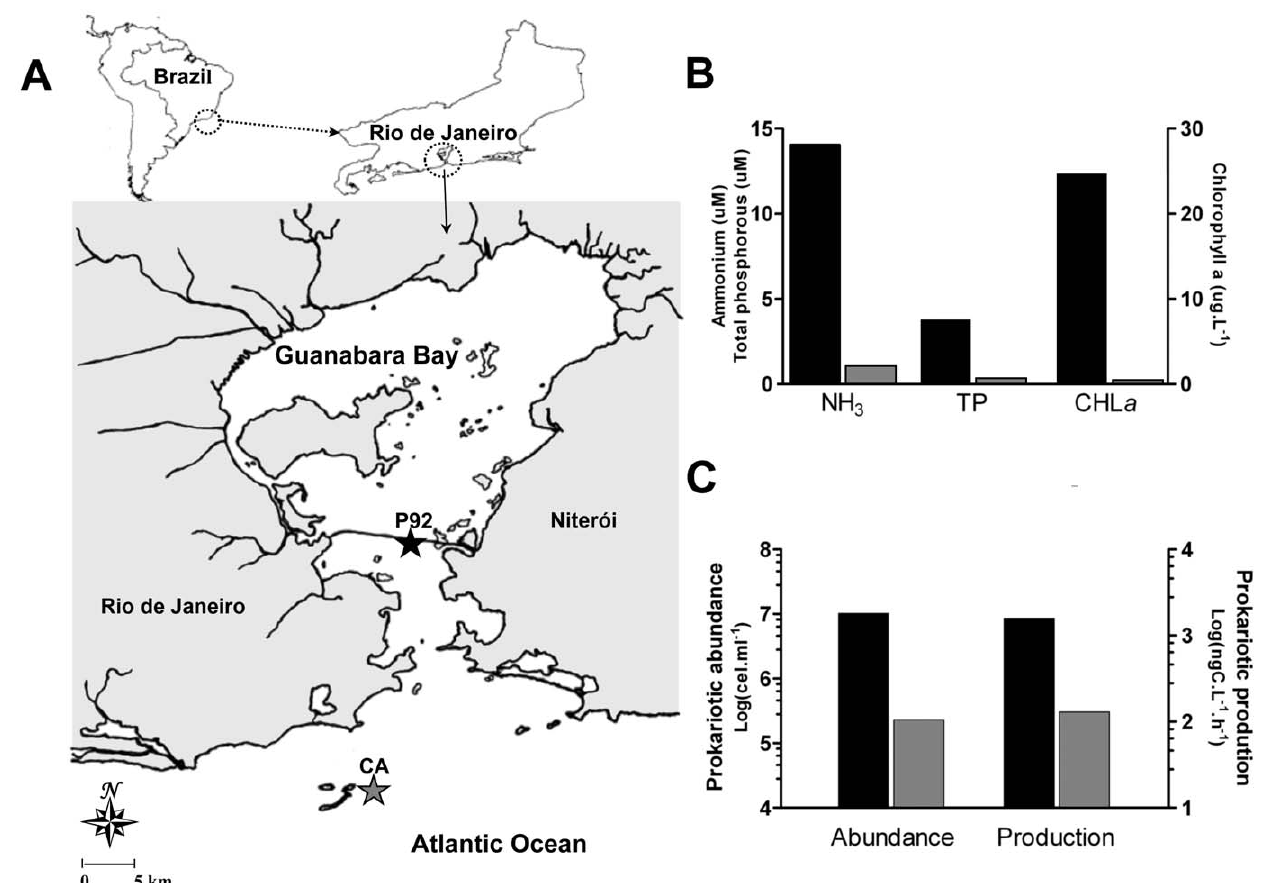
Figure 1. Location of sampling sites, seawater trophic status and planktonic microbiological parameters in Rio de Janeiro. (A) The location of Guanabara Bay in South America is indicated on the map (upper left corner). The map on the upper right corner shows the location of Guanabara Bay in reference to Rio de Janeiro state. The lower panel shows a detailed map of Guanabara Bay and the location of the two sampling sites: the pillar 92 of the Rio-Nitero´i Bridge, the inner bay site (P92) and the Cagarras Archipelago (CA), the outer bay site. (B) Ammonium, phosphate and chlorophyll a concentrations in seawater inside (black bars) and outside Guanabara Bay (gray bars). (C) Planktonic prokaryotic abundance and production inside (black bars) and outside the bay (gray bars).